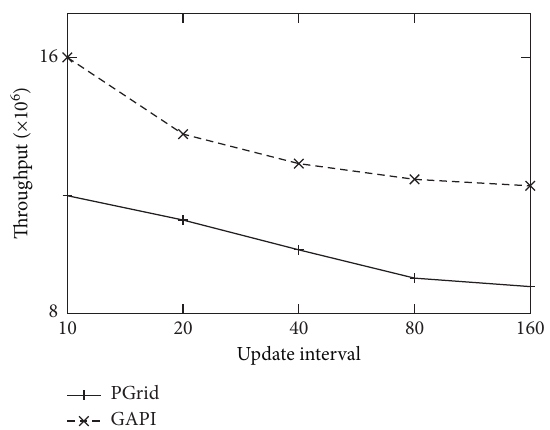
Figure 5: Effect of throughput on the interval between updating.